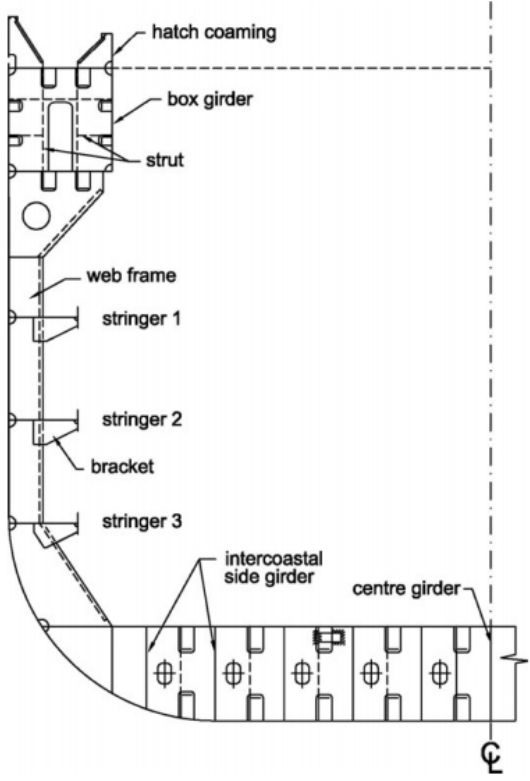
Figure 1: Midship of a container ship [35].